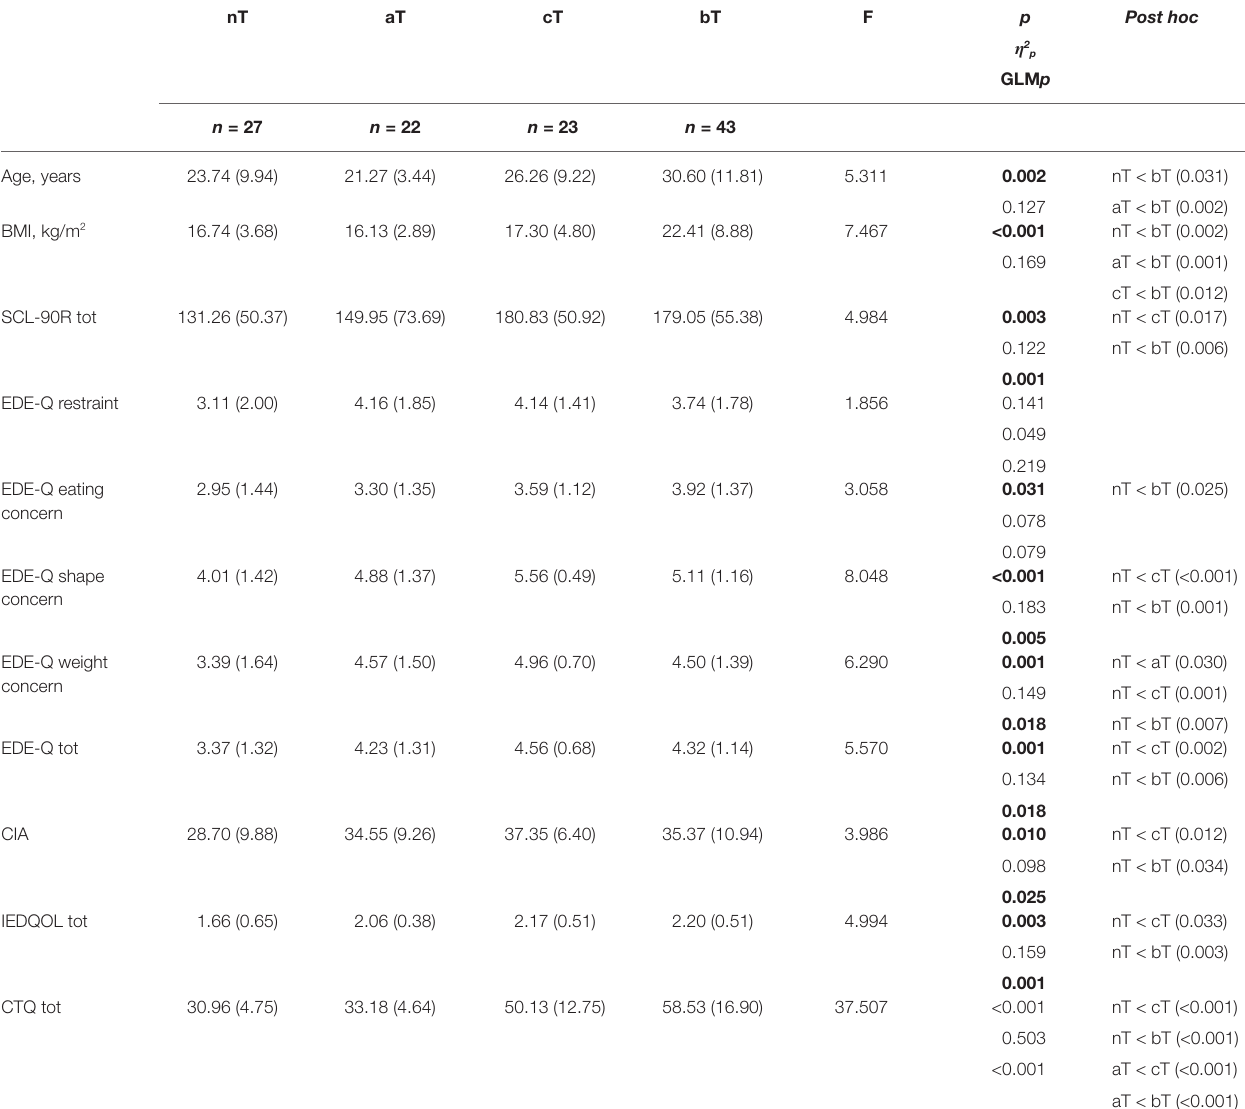
TABLE 1 | Clinical presentation of the